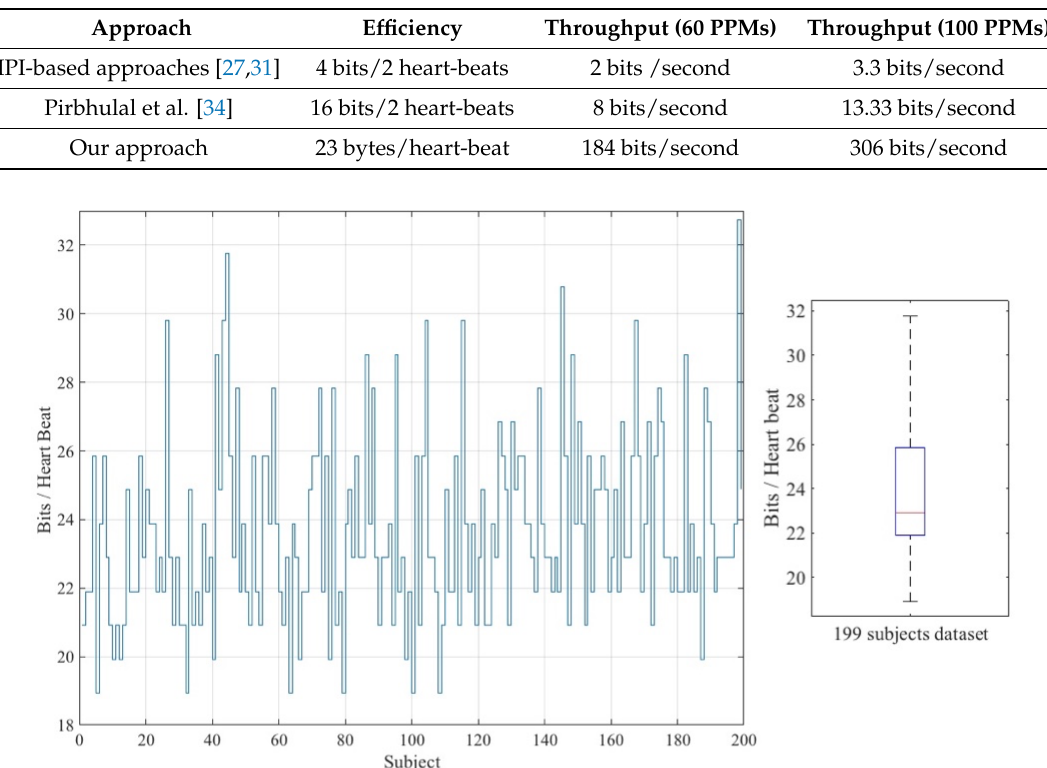
Figure 6. Throughput